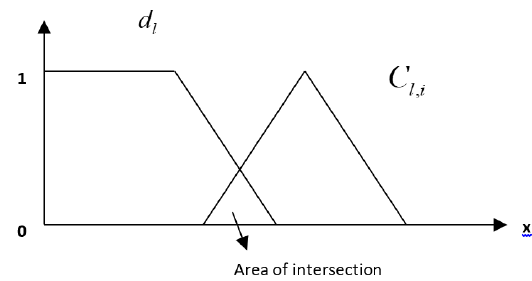
Fig. 4. Satisfaction Grade